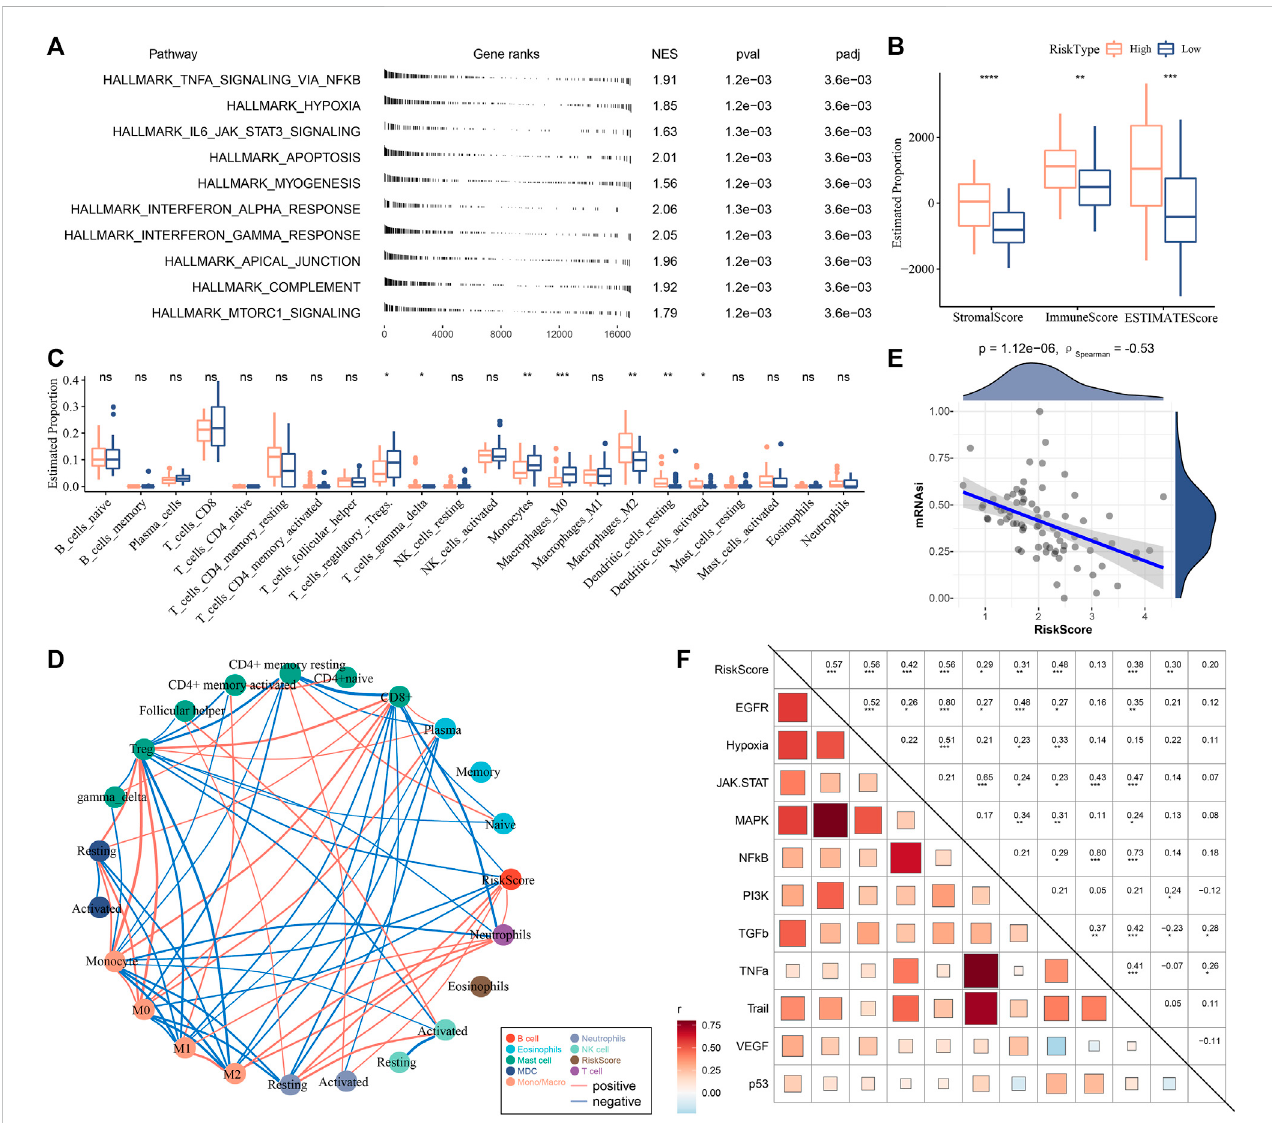
FIGURE 6 Analysis of biological pathways and immune microenvironment in two risk groups in E-MTAB-6389 cohort. (A) GSEA results of signi fi cantly enriched pathways in high-risk group. (B) ESTIMATE analysis showed immune score, stromal score and ESTIMATE score of two risk groups. Wilcoxon test was conducted. (C) CIBERSORT analysis showed the enrichment of 22 immune cells in two risk groups. Wilcoxon test was conducted. (D) Pearson correlation analysis of risk score with immune cells. Red and blue lines indicate positive and negative correlation respectively. (E) Spearman correlation analysis between mRNAsi and risk score. (F) Pearson correlation analysis of risk score with oncogenic pathways. ns, not signi fi cant. * p < 0.05, ** p < 0.01, *** p < 0.001, **** p <